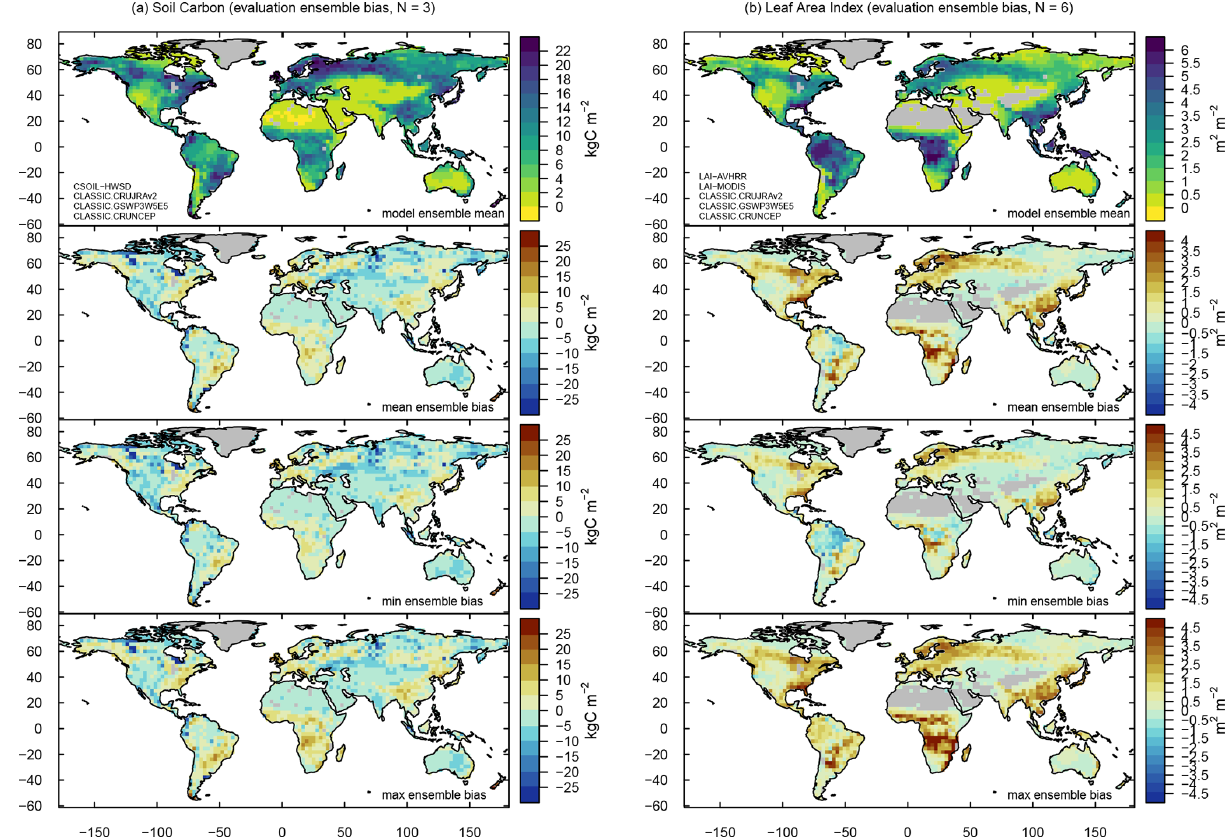
Figure A23. Same as Fig. 7 but for (a) soil organic carbon mass and (b) leaf area index.